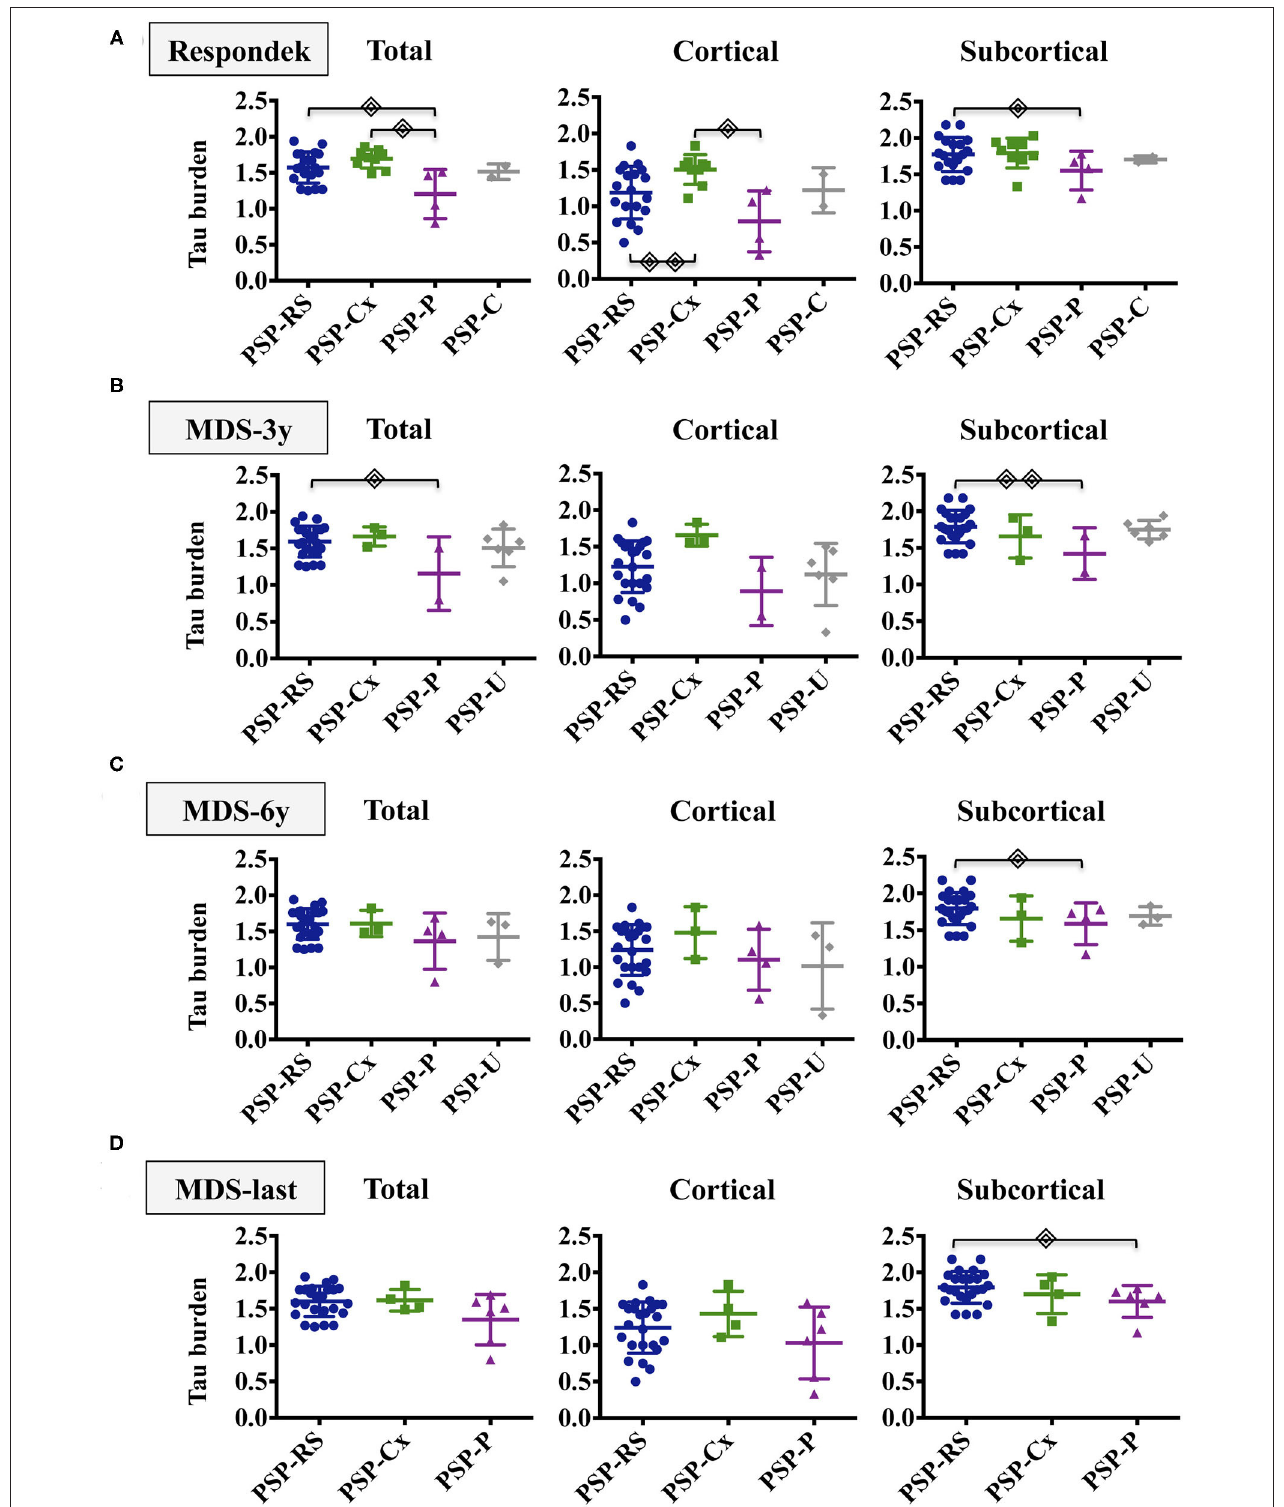
FIGURE 3 | Tau burden distribution in PSP phenotypes. The figure shows the total, cortical and subcortical semiquantitative tau loads in the different PSP phenotypes after applying Respondek’s (A) , MDS-3y (B) , MDS-6y (C) and MDS-last (D) criteria. Simple linear regressions were computed to evaluate group differences between PSP subtypes adjusting by age of onset and Braak stage. ( p < 0.05), ( p < 0.01). Non-significant differences were not displayed. PSP-RS/PI, Richardson Syndrome spectrum; PSP-Cx, PSP cortical predominant phenotypes; PSP-P, PSP with predominant parkinsonism; PSP-U, unclassified